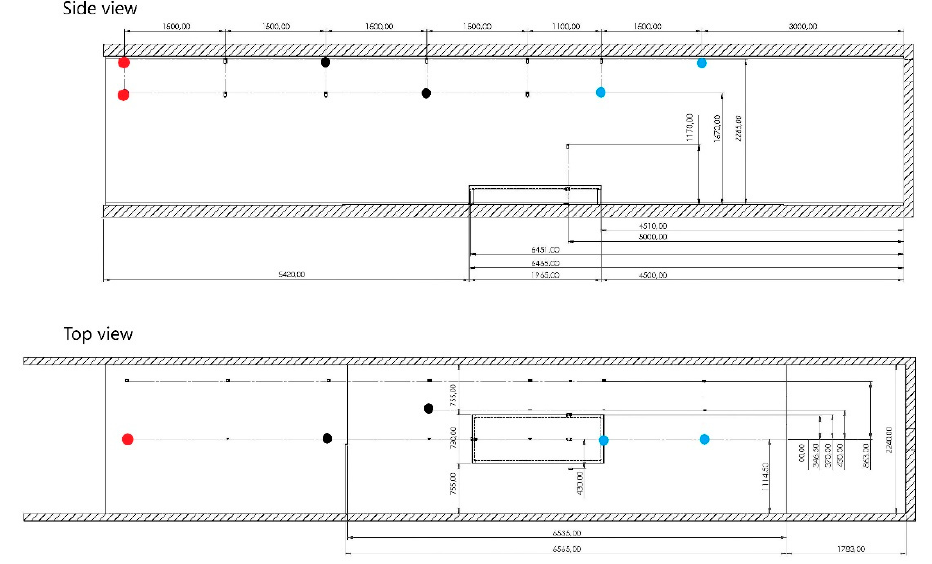
Figure 3. Location of the hydrogen sensors. Circle markers: red—S1, S2; black—S5, S21; blue—S13, S12.